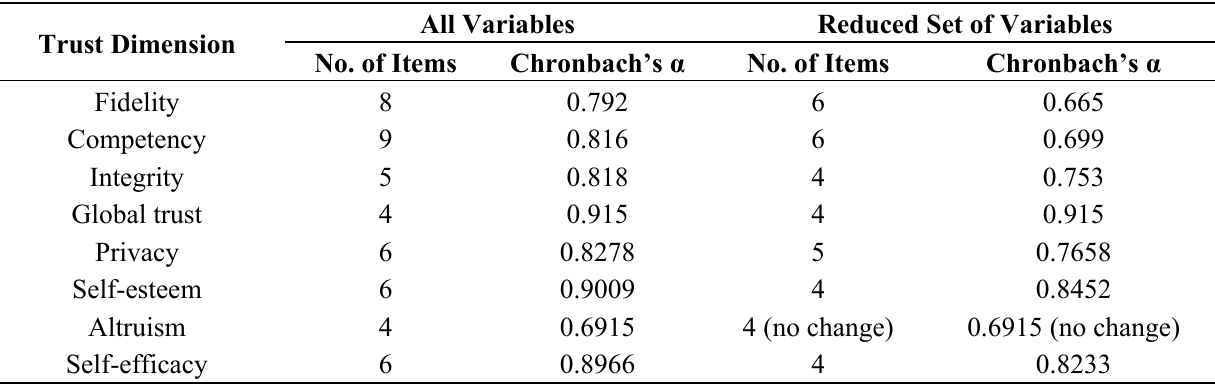
Table 1. Chronbach’s Alpha for Indices.